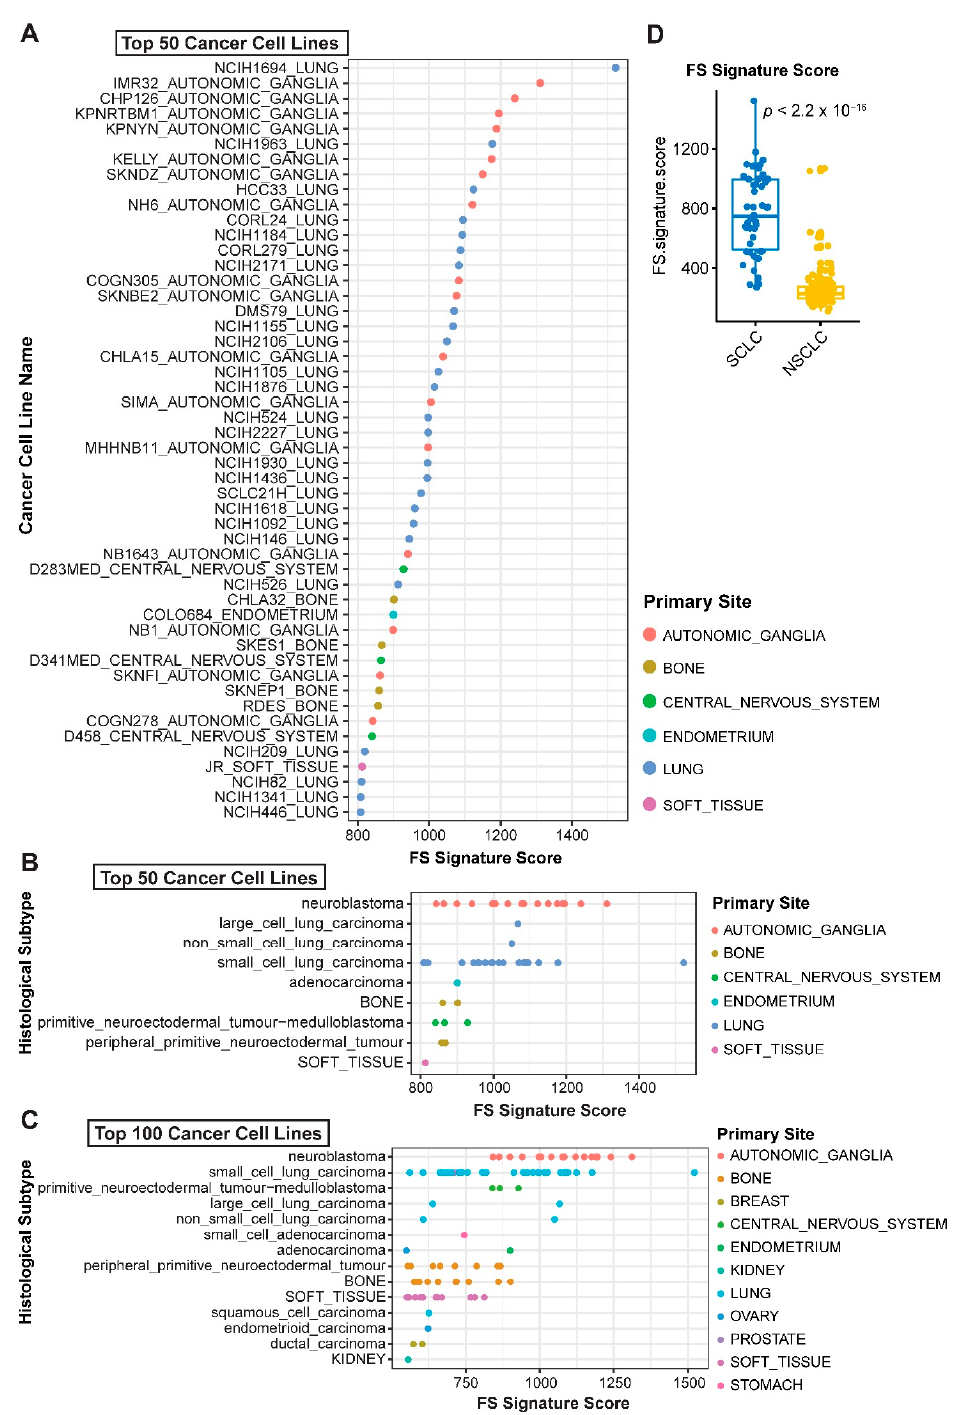
Figure 6. Predictive values of ferroptosis gene signature across pan-cancer cell lines. ( A – C ), Ferroptosis sensitivity was scored across solid pan-cancer cell lines based on the newly curated ferroptosis sensitivity gene signature. Normalized transcriptomic data were downloaded from CCLE project. ( D ), Significant di ff erence (by unpaired two-sided t-test) of the FS gene signature score between small cell lung cancer (SCLC) and